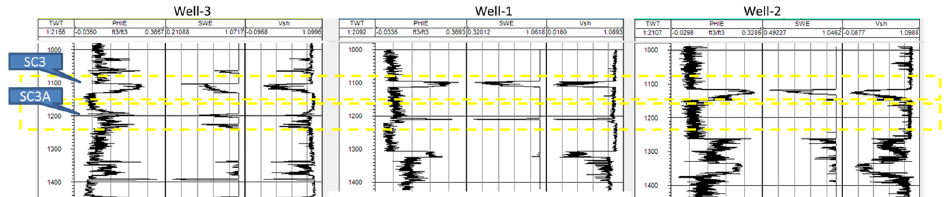
Figure 4. Petrophysical (porosity PHIE, water saturation SWE and volume of shale VSH) logs data from Well 1, Well 2 and Well 3 are used for inversion. Two yellow dashed-line rectangles locate two interested gas reservoirs.